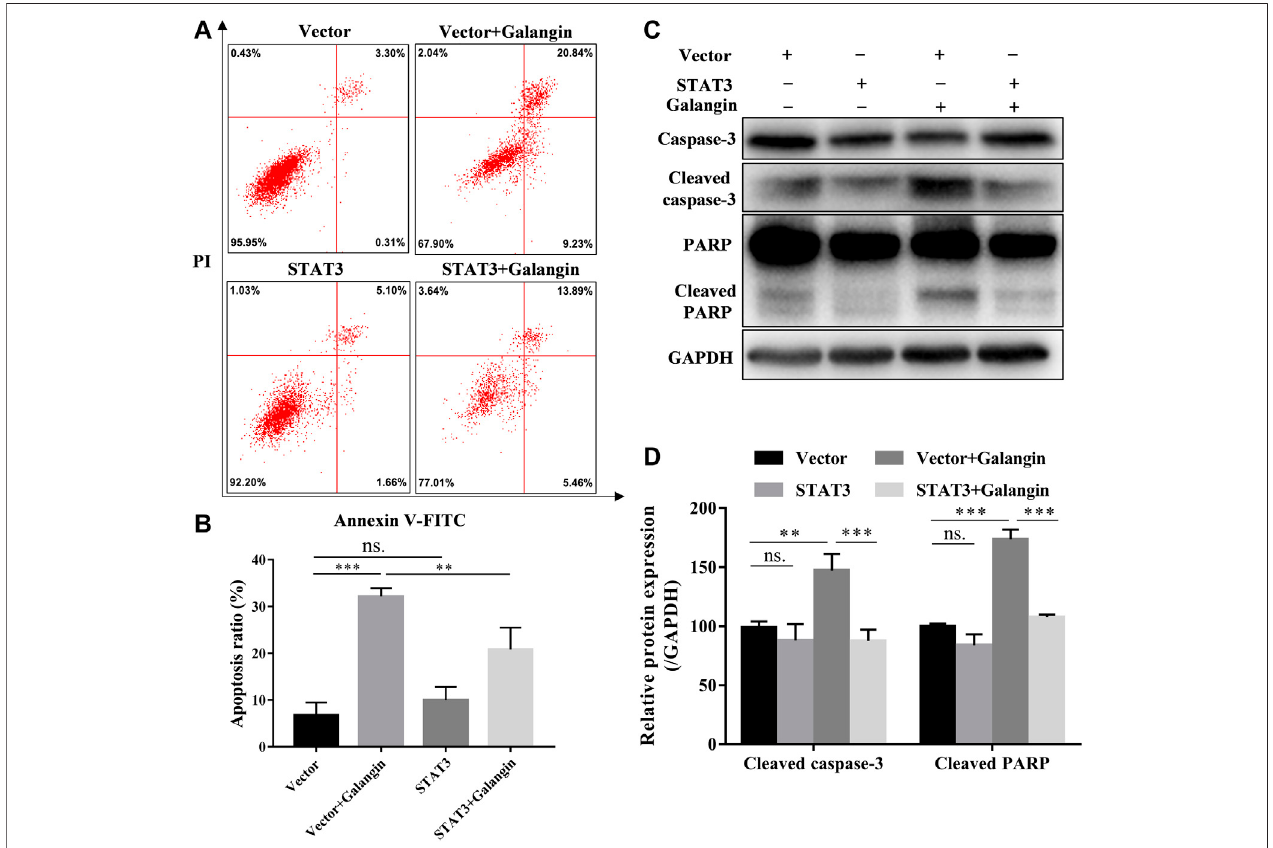
FIGURE 5 | STAT3 overexpression counteractes the effect of galangin on cell apoptosis in MGC 803 cells. (A – B) STAT3 overexpression abolished the effect of galangin (20 μ M) on cell apoptosis of MGC 803 cells after treatment for 48 h, detected by Annexin V/PI staining. (C – D) Overexpression of STAT3 reversed the effect of galangin(20 μ M) onprotein expression ofcleaved caspase-3 andcleaved PARPinMGC803cells. Allofthedatawereshown asmean ± SD,and differences among ≥ 3 groups ( Figures 5B,D ) were analyzed by one-way ANOVA with Tukey test by using GraphPad 7.0 software; ** p < 0.01; *** p < 0.001. n ≥ 3.